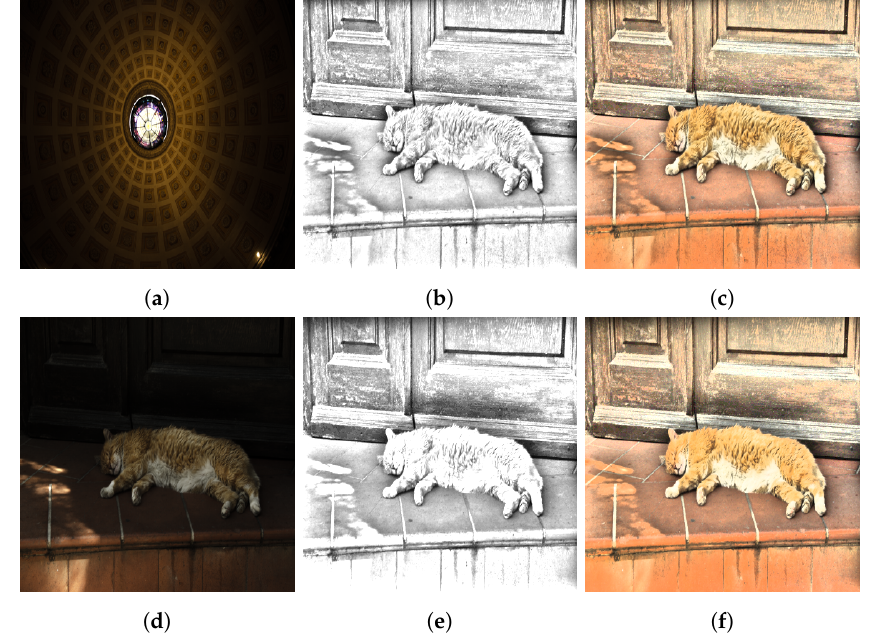
Figure 4. Results of using different images for training and test in a single image: ( a ) Training image; ( b ) Reflectance using CSC dictionary; ( c ) Image enhancement using CSC dictionary; ( d ) Original Test image; ( e ) Reflectance using sparse coding dictionary; ( f ) Image enhancement using sparse coding dictionary.